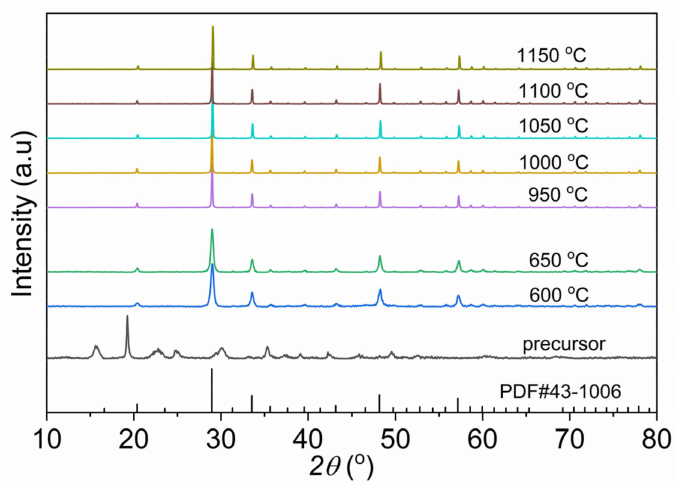
Figure 5. XRD patterns of the precursor and the Dy 2 O 3 powders calcined at 600, 650, and 950–1150 ◦ C. Table 1. The specific surface areas (S BET ), average particle sizes (D BET ) and average crystallite sizes (D XRD ) of the Dy 2 O 3 powders calcined at 950–1150 ◦ C for 4 h. Temperature ( ◦ C) S BET (m 2 /g) D BET (nm) D XRD